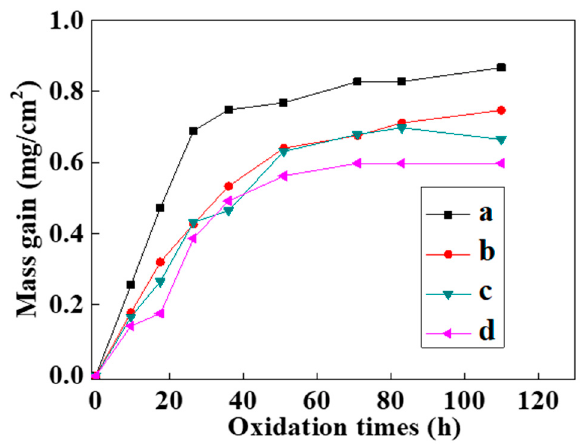
Figure 8. Static oxidation kinetics curves of the NiCrAlY bond coat at 900 °C before and after a high ‐ current pulsed electron beam irradiation: ( a ) nonirradiated, ( b ) 12 J/cm 2 , ( c ) 15 J/cm 2 , ( d ) 18 J/cm 2 .